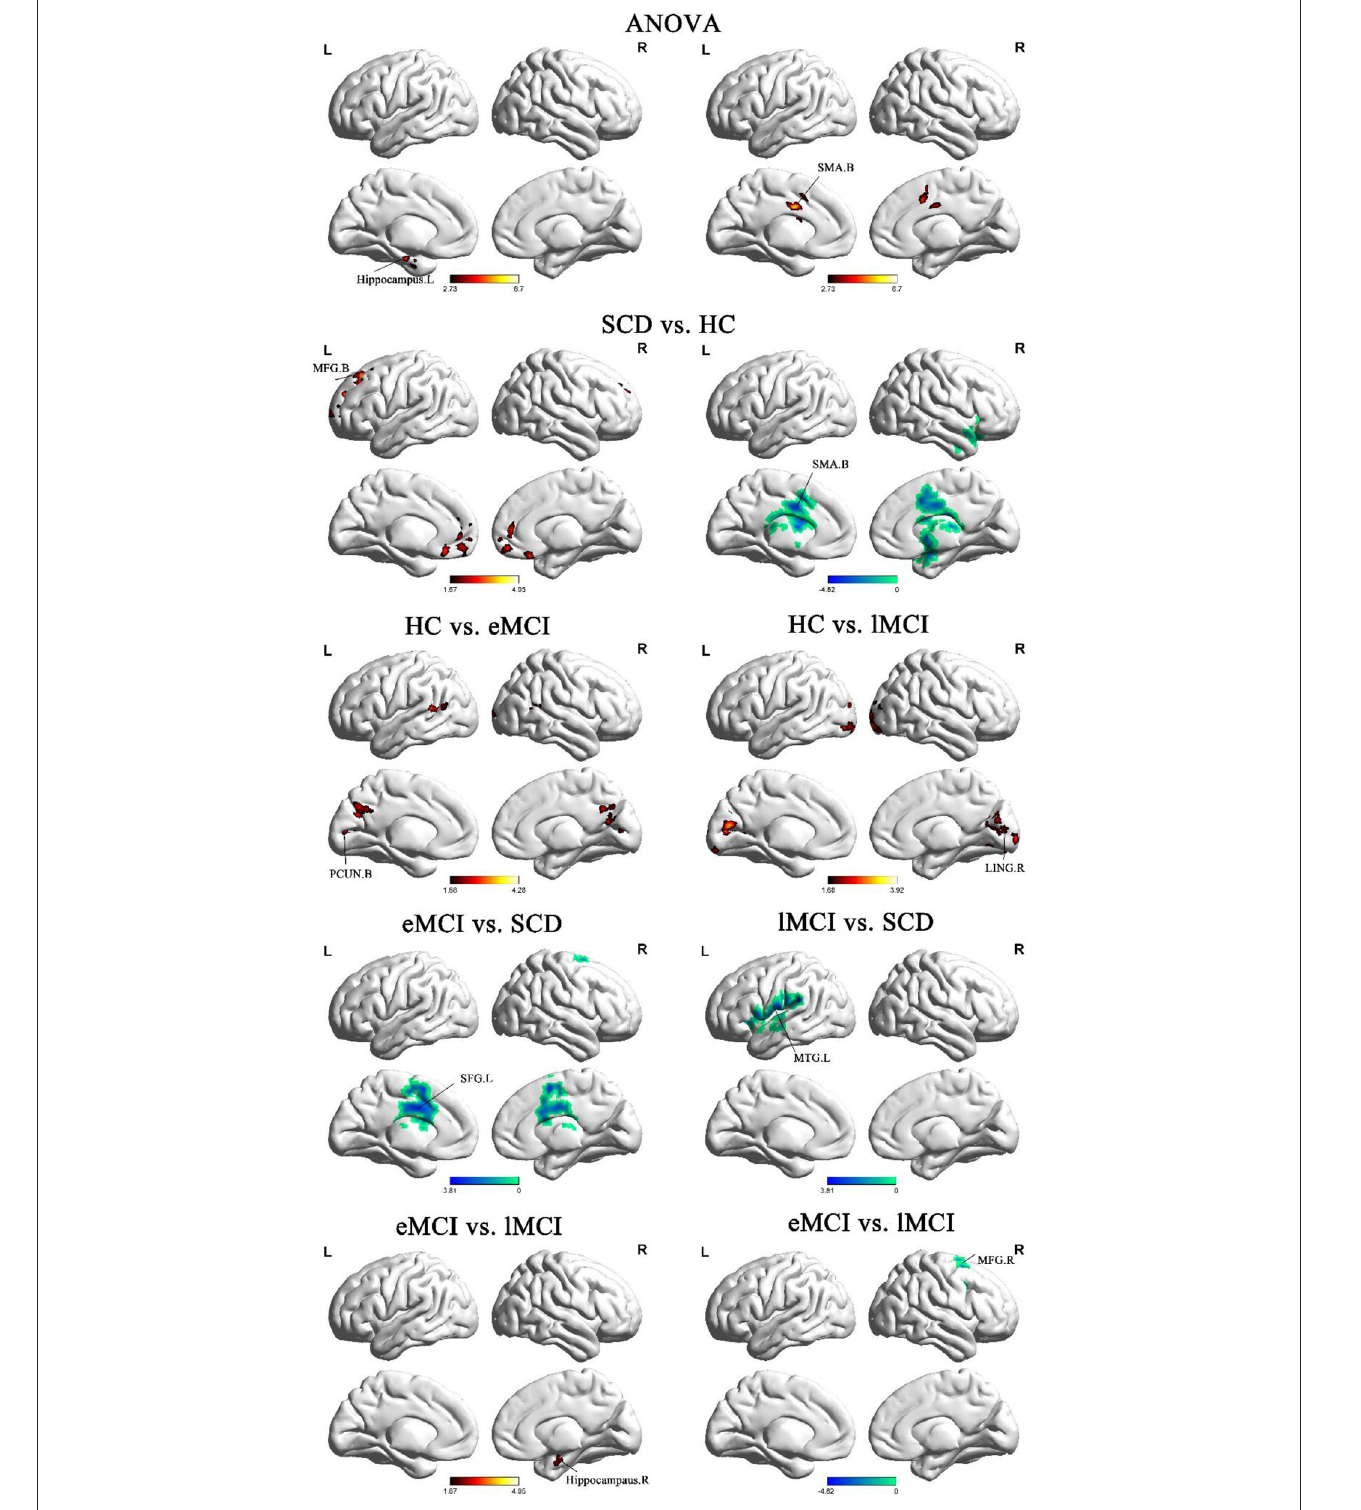
FIGURE 1 | Brain regions exhibiting significant differences in BNM-FC based on analysis of variance (ANOVA) analysis and two-sample t -tests. Age, gender, and years of education were used as covariates for all these results. GRF corrected, cluster size ≥ 50 mm 3 , p < 0.05. eMCI, early mild cognitive impairment; lMCI, late mild cognitive impairment; SCD, subjective cognitive decline; HC, healthy controls; SMA, supplementary motor area; PCUN, precuneus; SFG, superior frontal gyrus; MFG, middle frontal gyrus; MTG, middle temporal gyrus; LING, lingual gyrus; L, left hemisphere; R, right hemisphere; B, bilateral hemisphere.